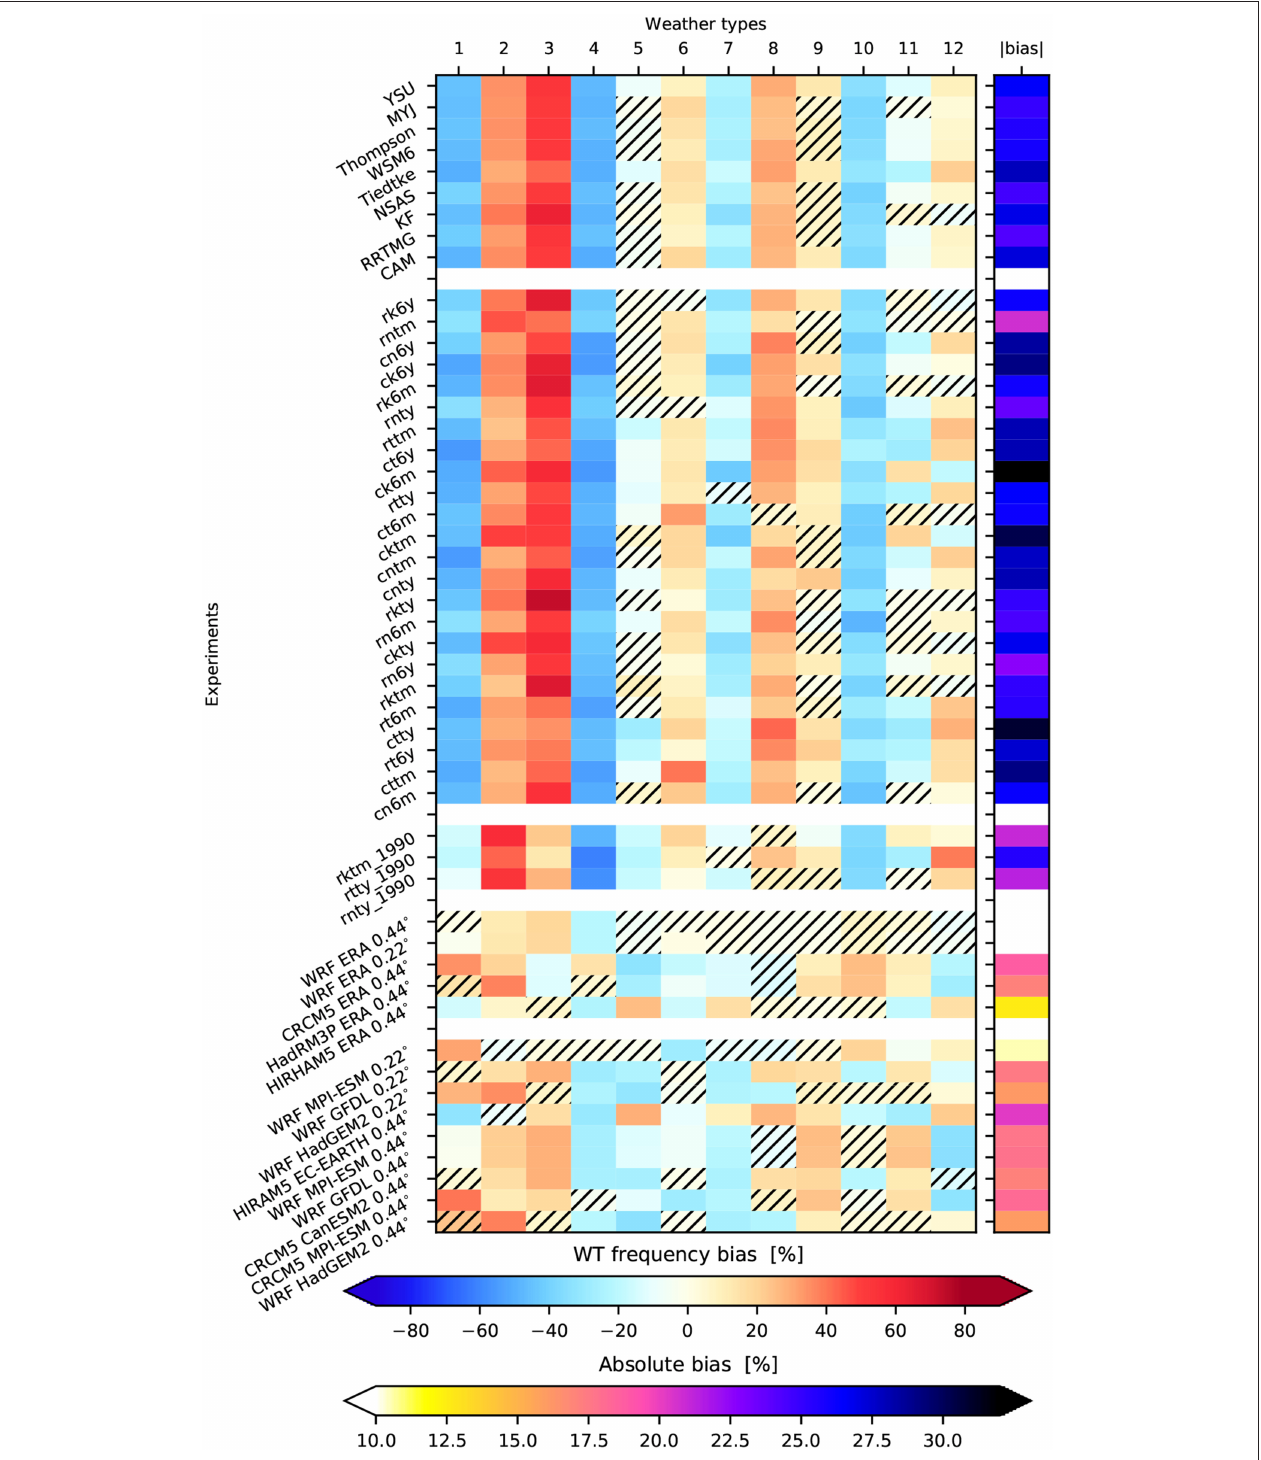
FIGURE 6 | Heatmap showing average WT frequency biases (smaller is better) for simulations (rows) and WTs (columns), and the absolute bias averaged over all WT biases in the rightmost column (lower color bar). The top block shows biases for WRF36 ERA-Interim simulations that use the same physics parameterization, e.g., the biases of all simulations that use the YSU PBL scheme are averaged. The second block from the top shows biases in the WRF36 simulations, and the central block shows biases in the CESM driven WRF36 hindcast runs. The second lowest block shows biases in ERA-Interim driven NA-CORDEX simulation while the lowest block shows NA-CORDEX hindcast driven biases for the period 1990–2000. Hatched rectangles show biases that are within the interannual variability of ERA-Interim WT frequencies.